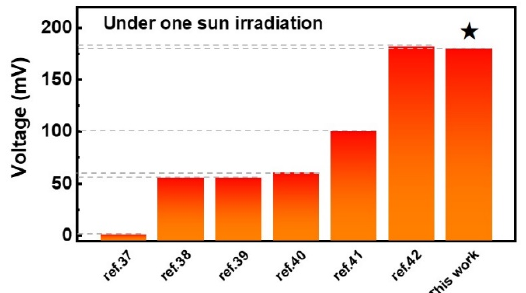
Figure 5. The output voltage of the solar thermoelectric generator compared to the literature [37–42]. The detailed performance in this work is shown in Figure